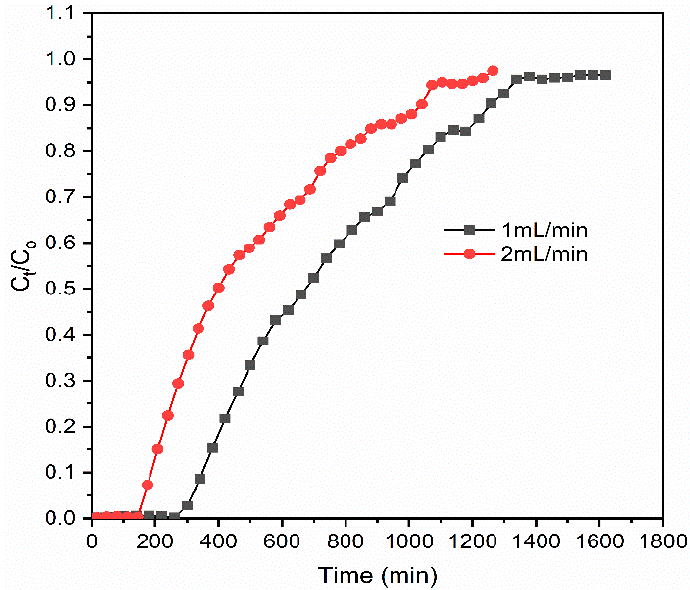
Figure 5. Effect of influent flow rate on phosphate breakthrough. Table 1. Obtained parameters from breakthrough curves for phosphate adsorption onto leftover coal material with differ- ent bed heights, initial phosphate concentrations, and flow rates.